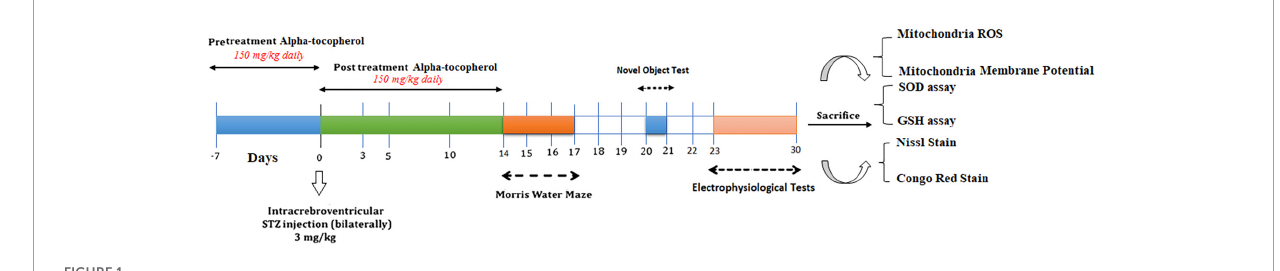
FIGURE1 Parameters measured and the time intervals are presented in a scheme of experimental